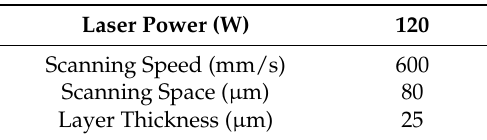
Table 2. The optimized SLM fabricating parameters.